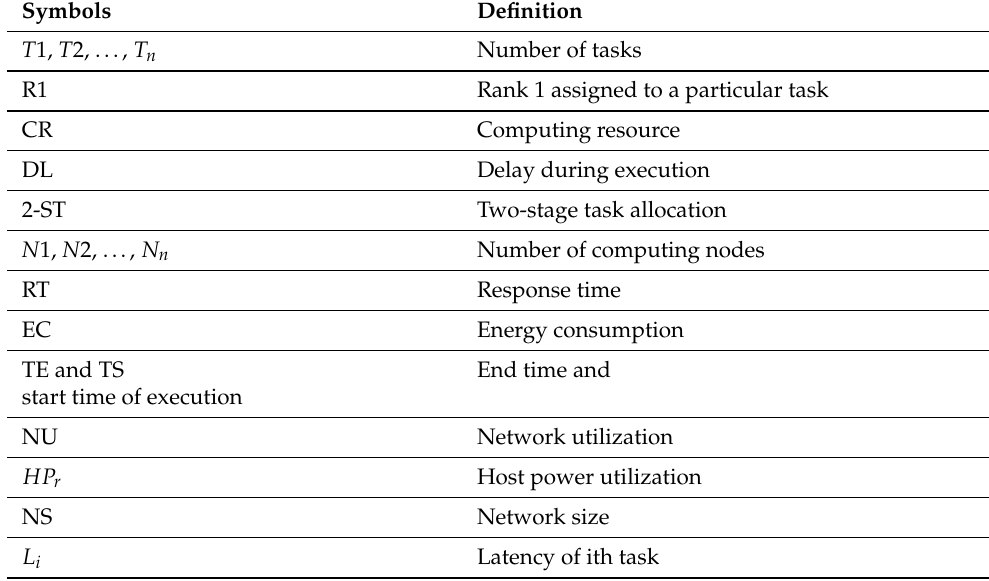
Table 2. List of